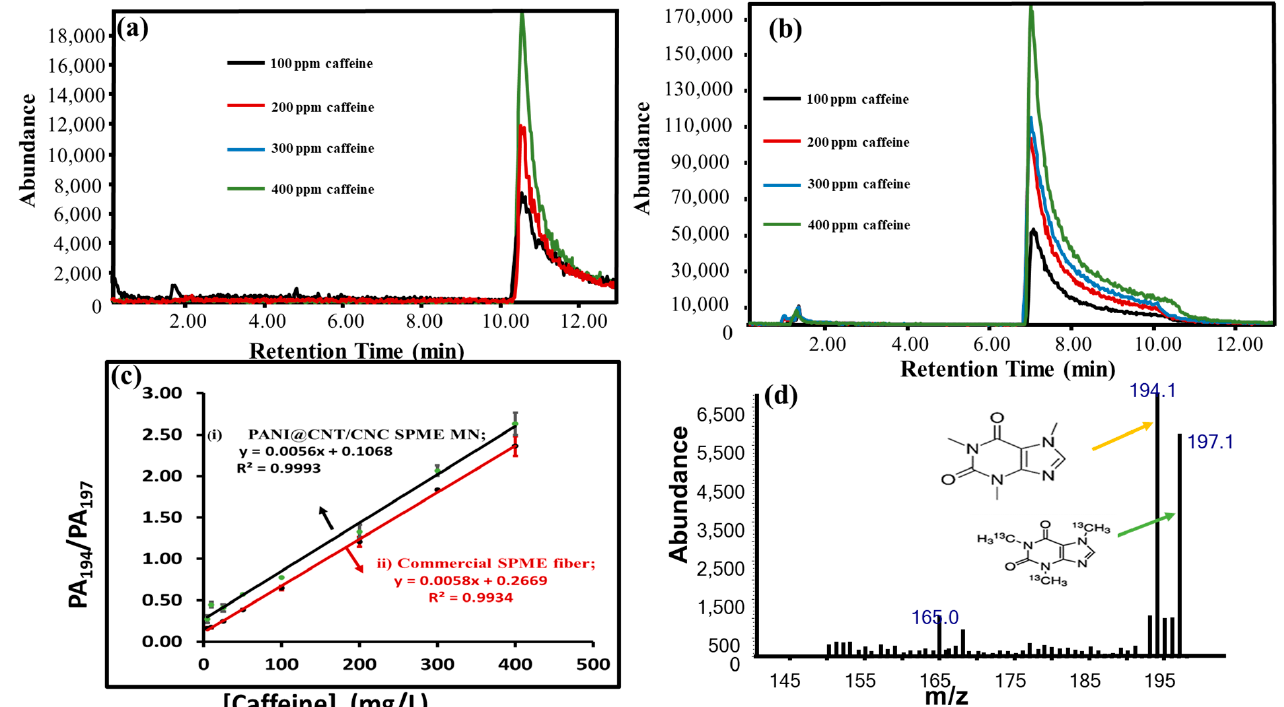
Figure 6. Overlaid extracted ion chromatograms (EIC) of GC-MS analysis of caffeine standards ( m / z = 194 ± 0.30) acquired following SPME using the ( a ) PANI@CNT/CNC SPME MN and ( b ) commercial SPME; ( c ) associated caffeine concentration vs. peak area of caffeine-194/peak area of caffeine-197 (PA 194 /PA 197 ) for caffeine extracted using the (i) PANI@CNT/CNC SPME MN and (ii) commercial SPME; ( d ) the mass spectra of extraction ion EIC for m / z 194 (caffeine standard) and m / z 197 (caffeine isotopic label internal standard) peaks.